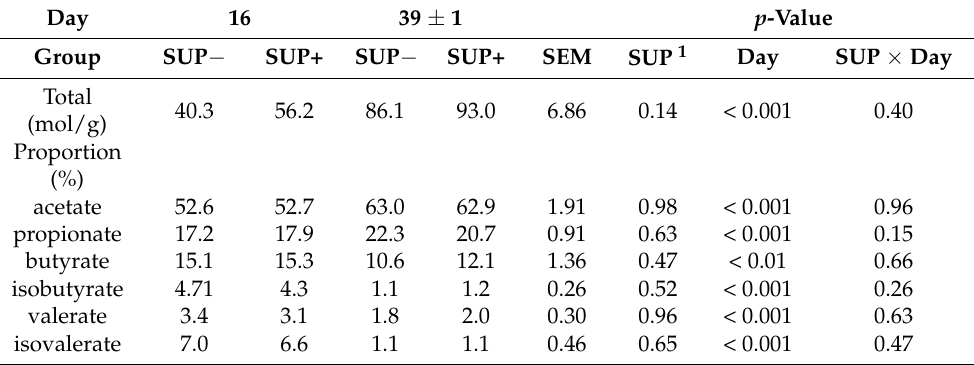
Table 2. Volatile fatty acid content in the feces of piglets from the unsupplemented (SUP − ) or supplemented (SUP+) groups on Day 16 of age and two weeks post-weaning (39 ± 1 d). The sup- plement, given at birth, consisted of a mixture of probiotics, prebiotics, immunoglobulins, vitamins, and